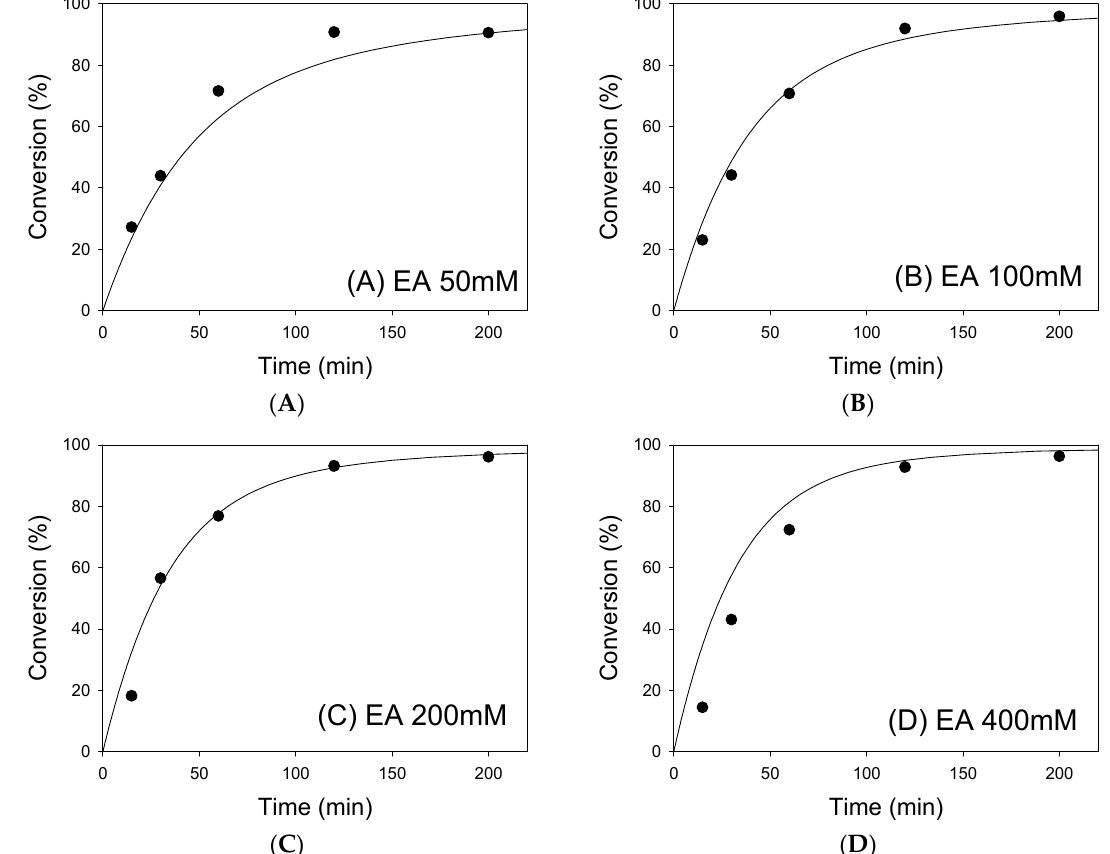
Figure 3. Comparison of experimental results and the simulated conversions obtained from the integrated rate equation (Equation (3)) using 50 mM DHA+EPA concentrate with ( A ) 50, ( B ) 100, ( C ) 200, and ( D ) 400 mM EA. Points are experimental data and lines are predicted from integrated rate equation (Equation (3)).